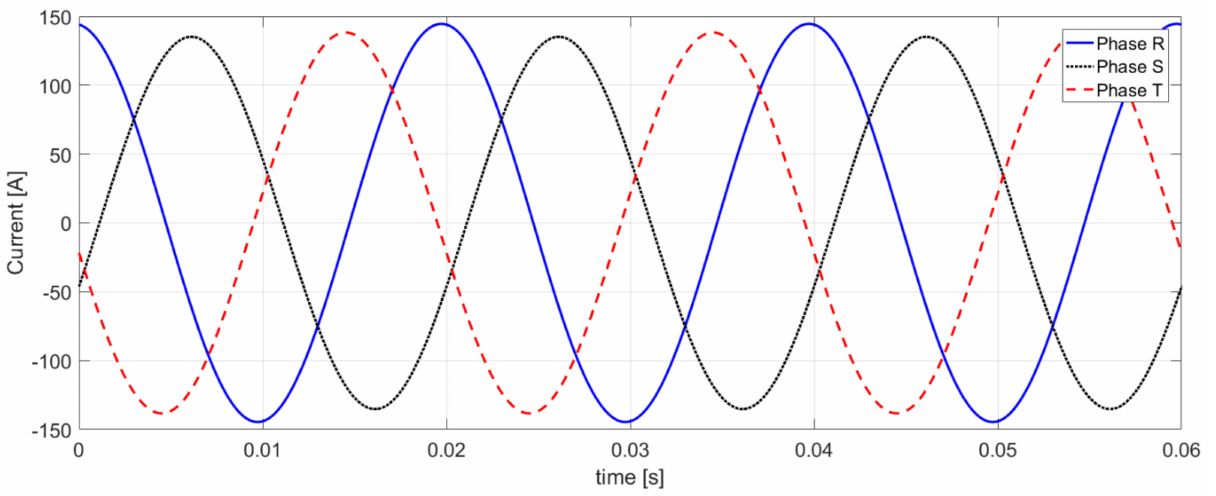
Figure 13. The waveform of three-phase sinusoidal active current in cross-section Z-Z’. The application of the active filtration expressed in relation (46) and the injection